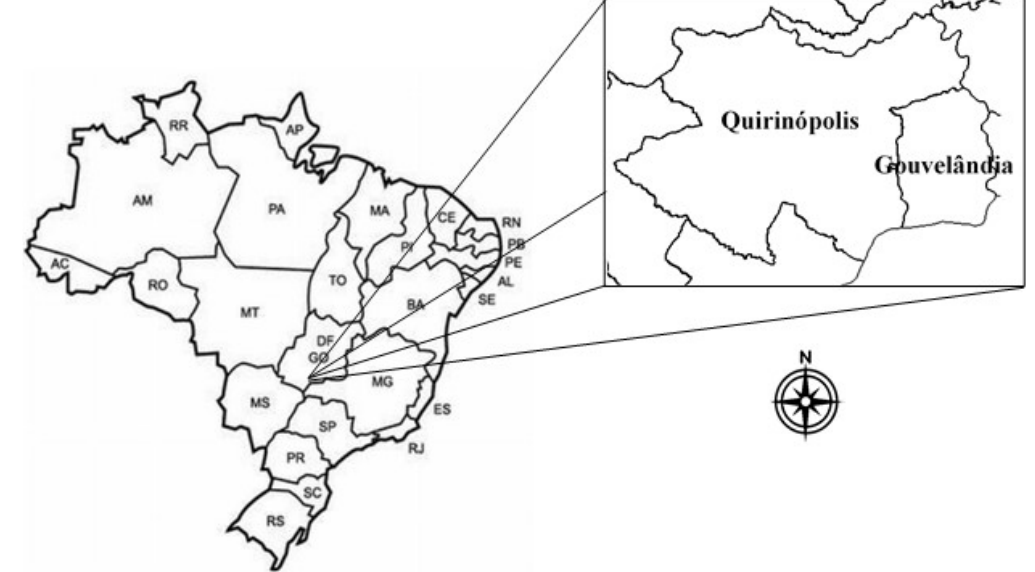
Figure 1 - Location of Quirinópolis and Gouvelândia municipalities, Goiás,